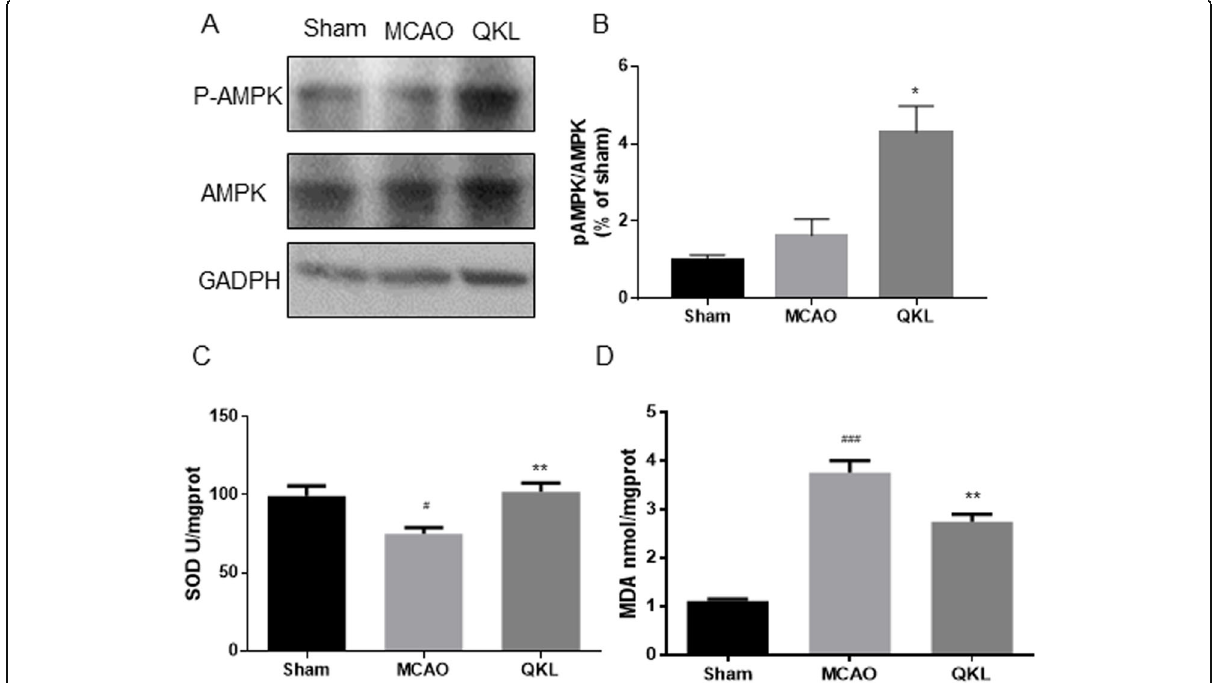
Fig. 6 QKL activated AMPK and decreased oxidative stress levels. a Western blot analysis of p-AMPK, AMPK and GAPDH. b Quantitative analysis of the p-AMPK: AMPK expression ratio. c Effect of QKL on the SOD level. d Effect of QKL on the MDA level. Data points indicate means ± SEM. Vs Sham group, # < 0.05, ### < 0.001, Vs MCAO group, * p < 0.05, ** p < 0.01. At least three independent experiments were performed for each